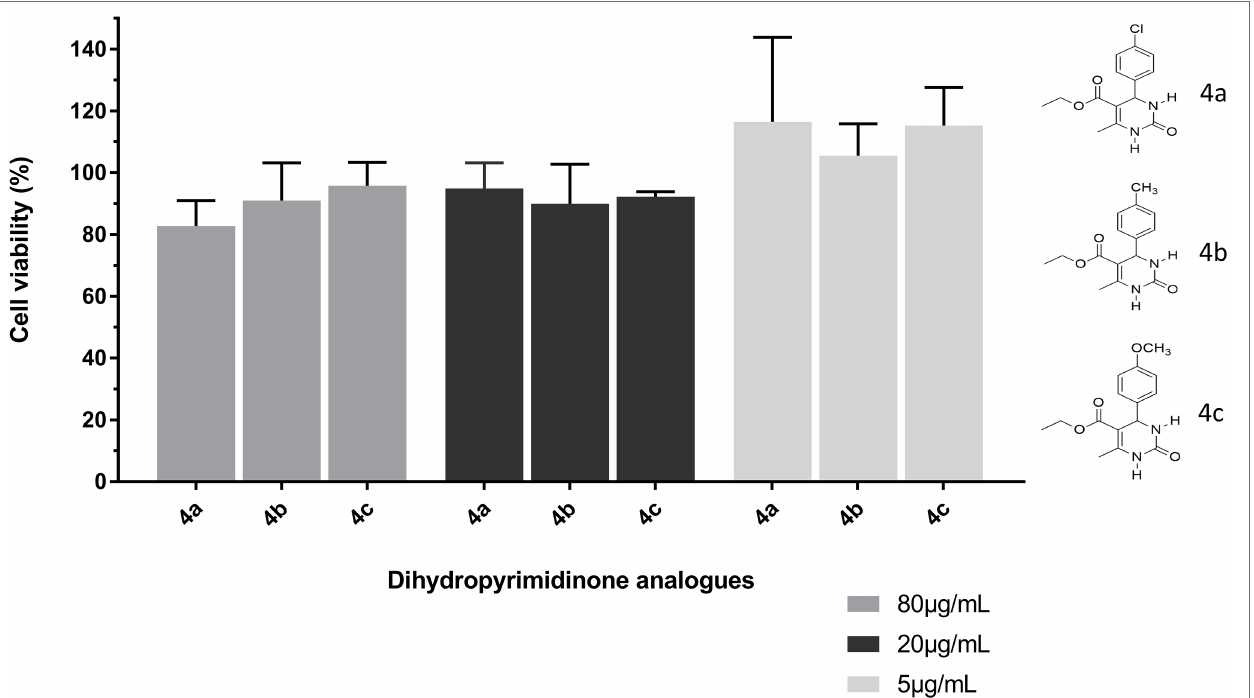
FIGURE 2 | Cytotoxicity of dihydropyrimidinone analogs 4a (4-chlorophenyl), 4b (p-toluyl), and 4c (4-methoxyphenyl) using the MTT assay. The compounds were tested at concentrations of 80, 20, and 5 μ g/ml and incubated for 24 h. The cell viability/proliferation using mouse fibroblasts of the 3T3 cell line (control = negative group representing cell viability of 100%) showed no difference among the groups ( p >